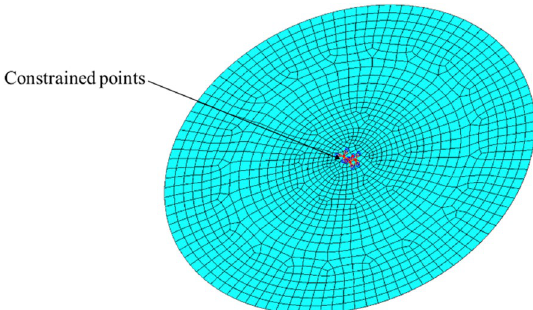
Figure 8 The meshing situation and the position of five fixed constrained points in the middle layer